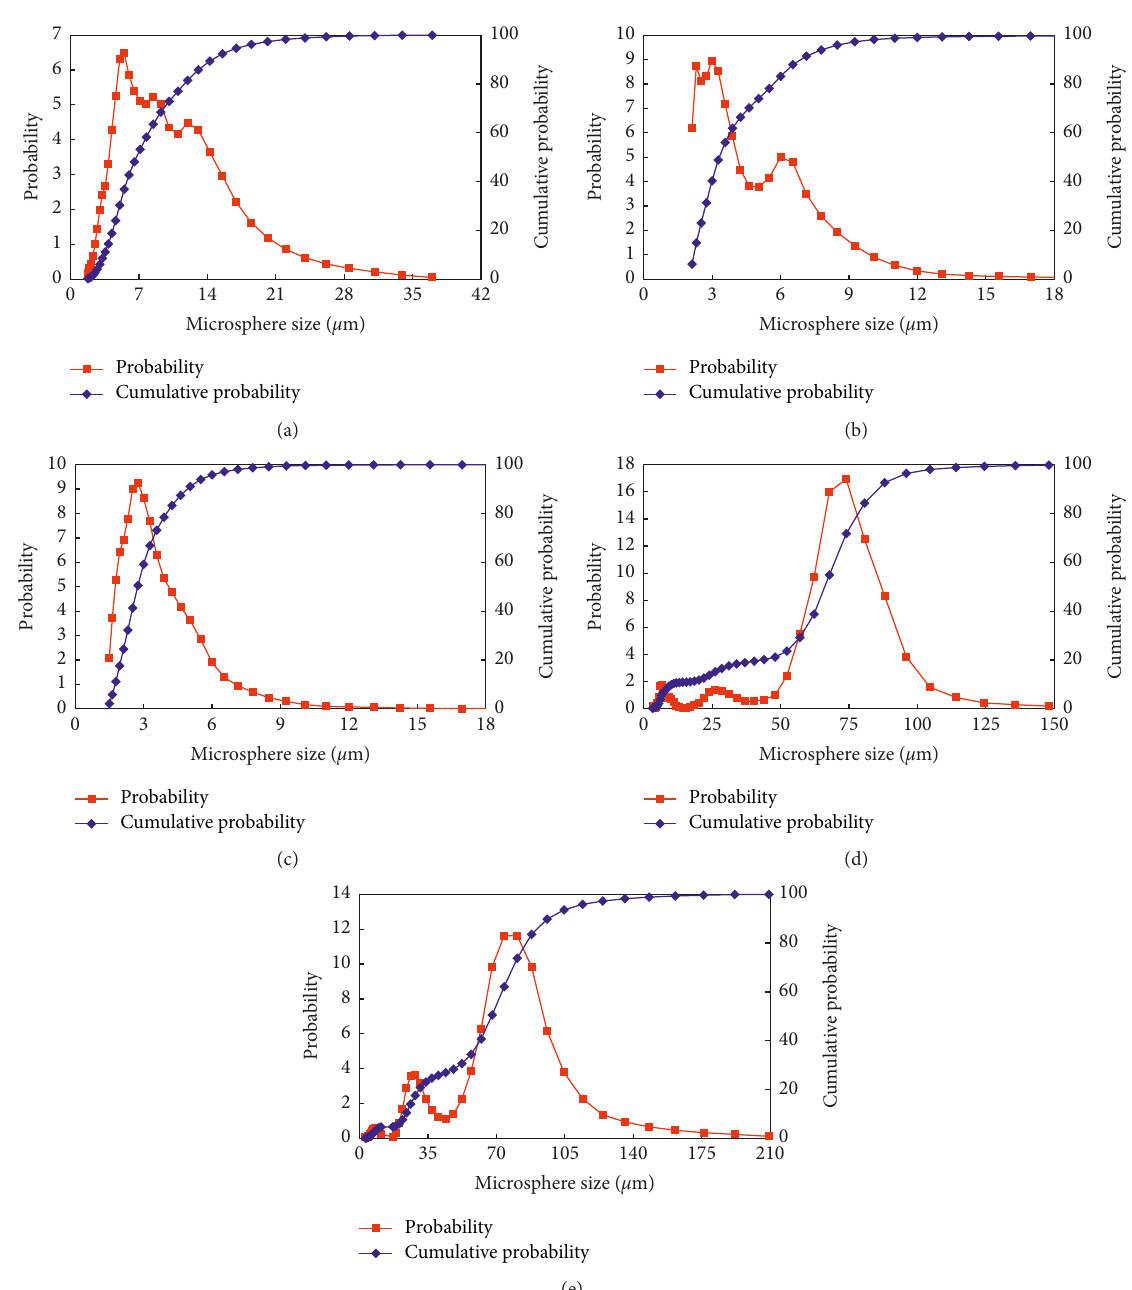
Figure 5: Core-shell microsphere size distribution at different periods of hydration: (a) 0 days, (b) 3 days, (c) 7 days, (d) 14 days, and (e) 21